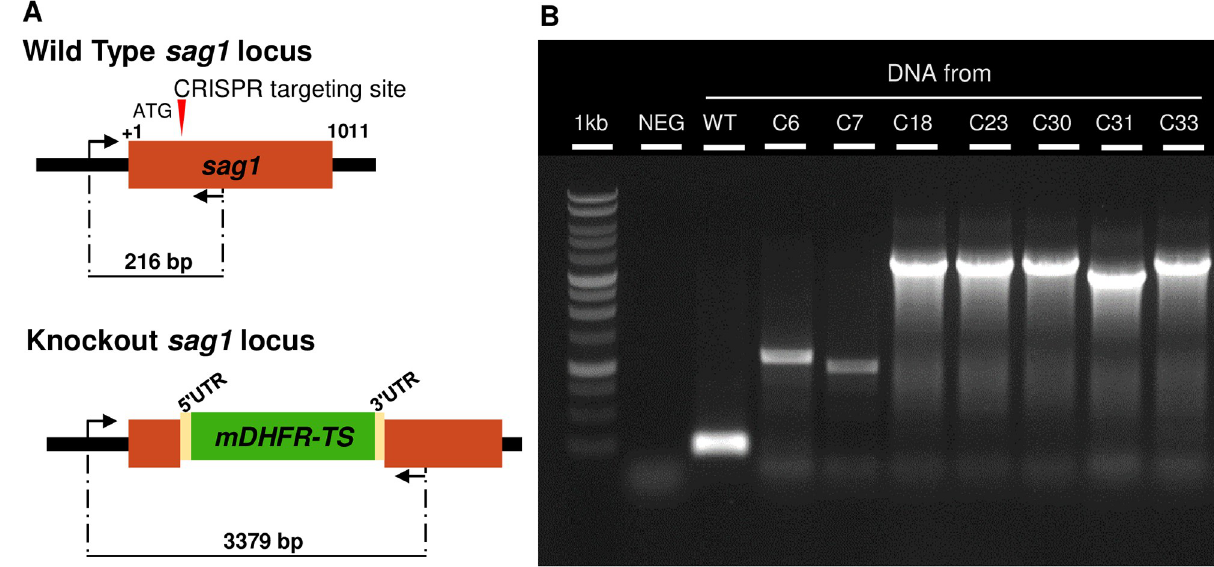
Fig 1. SAG1 gene disruption in T . gondii RH by CRISPR-Cas9 technology. ( A ) Schematic representation of the strategy used to disrupt sag1 by inserting the pyrimethamine-resistance gene MDHFR-TS. ( B ) Diagnostic PCR revealing integration of a complete mdhfr-ts sequence into sag1 in four clones (C18, C23, C30 and C33) compared with the parental strain RH. The KO clone C31 showed a smaller band, clones C6 and 7 exhibited a band � 1000 bp. The WT locus produced the expected PCR product (~ 216 bp).